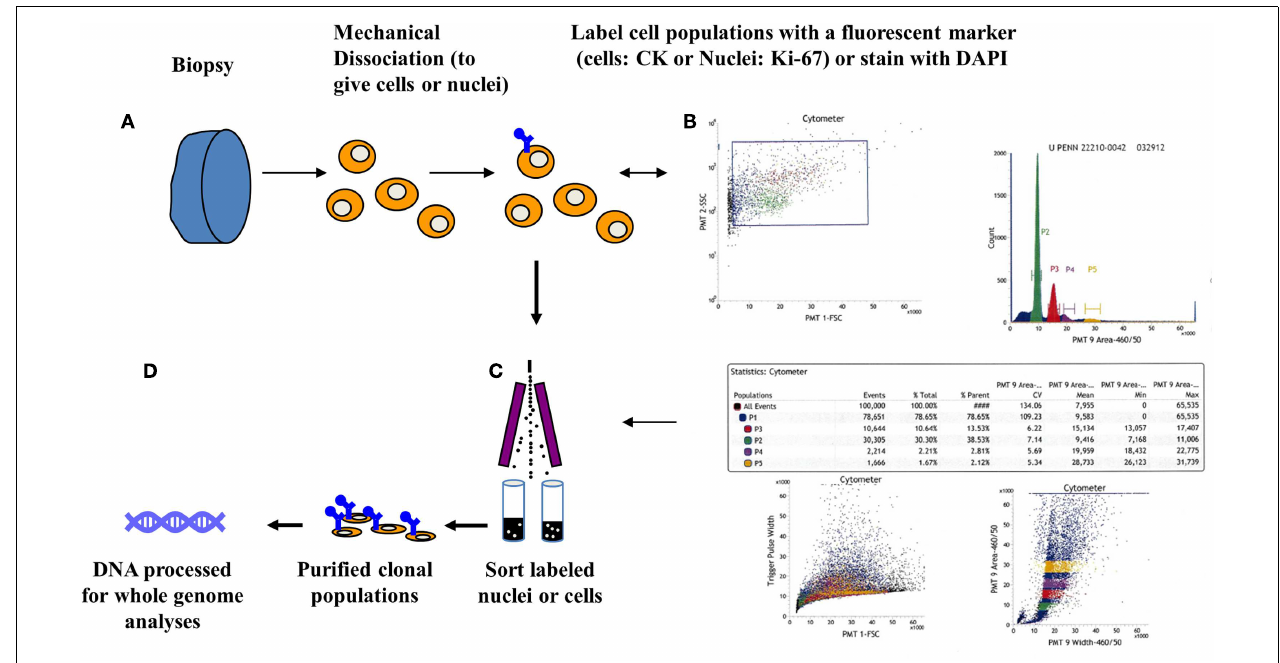
then subsequently sort populations of interest.Table displays quantitative analysis of the four peaks (P1–P4) detected in a pancreatic adenocarcinoma sample. (C) Each peak was sorted and collected into individual tubes. (D) Genomic DNA from each purified population is extracted then processed for assays of interest including whole genome and whole exome